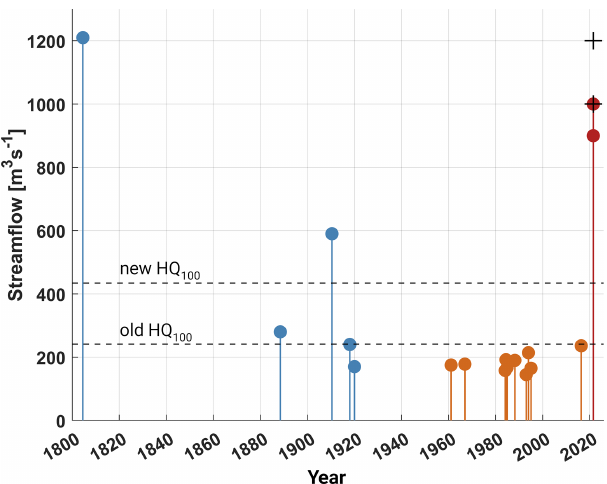
Figure 7. Time series of selected flood peaks at gauge Alte- nahr (Ahr). The blue dots are reconstructions (modified from Roggenkamp and Herget, 2022); the orange dots are the 10 largest floods in the gauge recordings (starting 1946), provided by the water authority of Rhineland-Palatinate; the red dots indicate the range of the 2021 flood peak estimated by the water authority of Rhineland- Palatinate; and the black crosses indicate the range of the 2021 flood peak estimated by Roggenkamp and Herget (2022) based on gauge recordings and reconstructions. The two dashed lines indicate the official HQ 100 estimates using only instrumental recordings (since 1946; old HQ 100 = 241m 3 s − 1 ) and a new approach including his- torical sources (new HQ 100 = 434m 3 s − 1